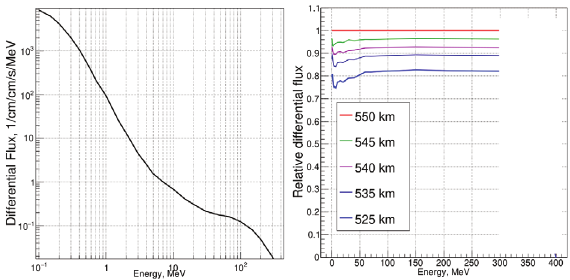
Figure 6: Left: Average di ff erential proton flux at 550 km height (SPENVIS [8]). Right: Relative variation of the di ff er- ential proton flux for di ff erent